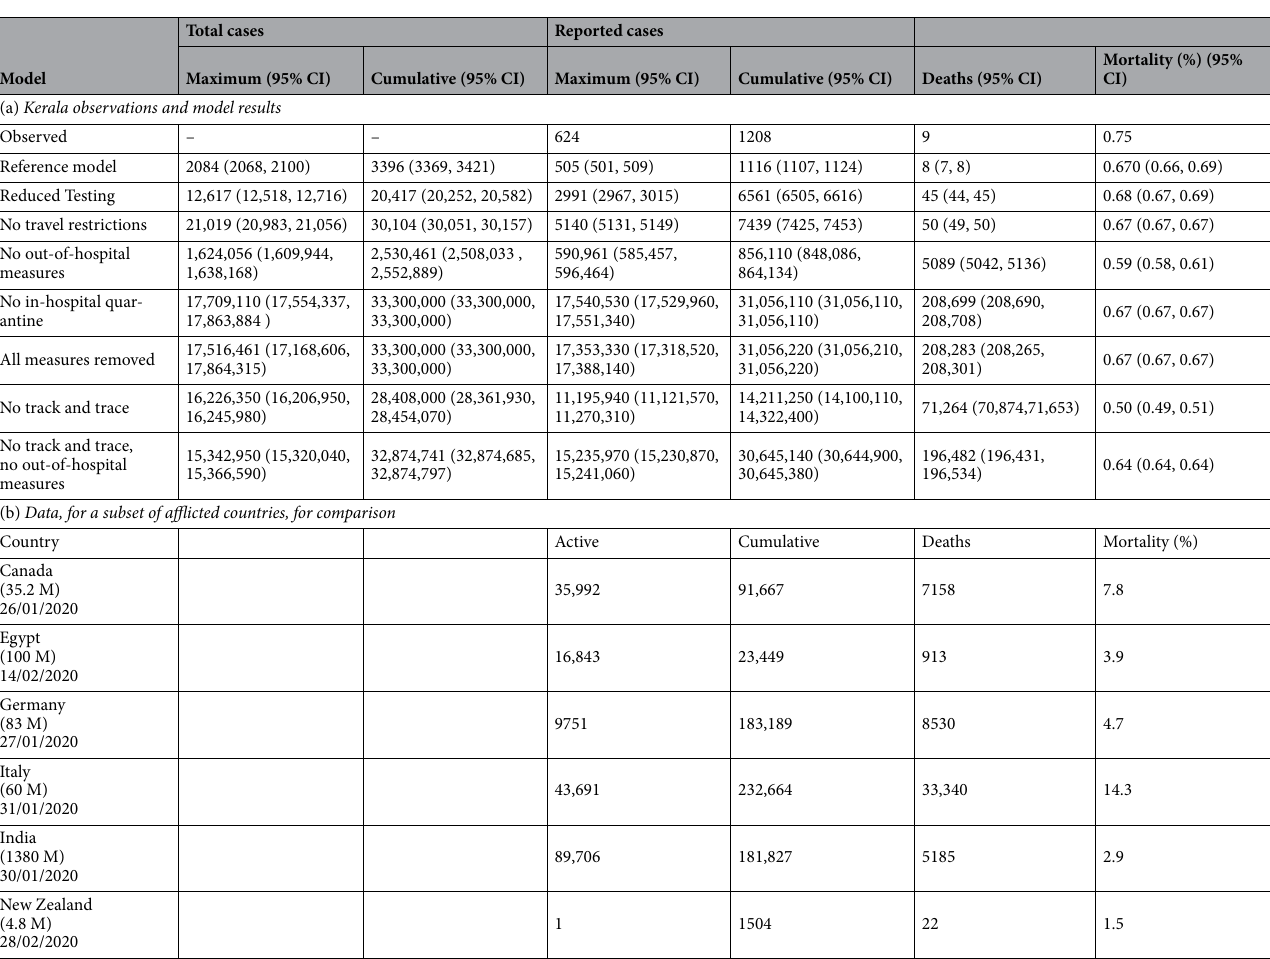
Table 1. Observations and model results. (a) Observations and results from the reference model run, along with runs varying the level of state intervention. Mortality is calculated as the ratio of deaths to cumulative hospitalised cases. The maximum corresponds to the number of people modelled as being in hospital at the end of the study period. (b) Observations from other countries, and India including Kerala, for comparison. All snapshots are for 30th May, 2020, with the date of introduction given in the first column. The total population of each country is given in parentheses in the first column, in units of millions (M). Timeseries for these countries are shown in Fig.